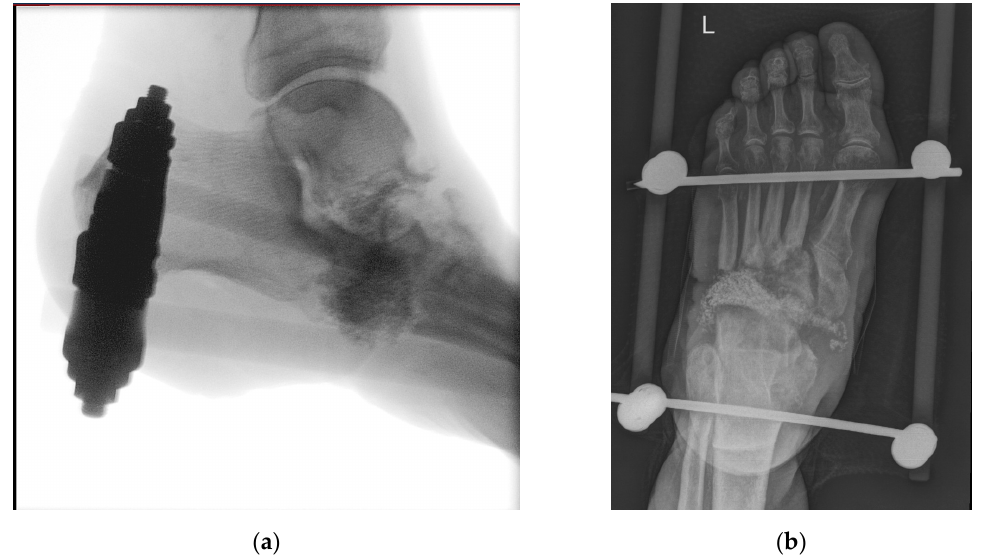
Figure 2. ( a ) Intraoperative X-ray—resection of cuboid bone, base of 4th and 5th metatarsal bones as well as head of talus due to osteitis, placement of bioactive glass granules, and an external fixator. Image captured intraoperatively with diascopy using Siemens Cios Alpha ® (Siemens, Munich, Germany) (average exposition parameters: 52 kV, 0.03 mAs, and 7.5 fps); ( b ) patient three months after resection and bioactive glass insertion. Image captured with Philips Digital Diagnost ® (Philips, Amsterdam, The Netherlands) (exposure parameters: 63 kV and 2 mAs).